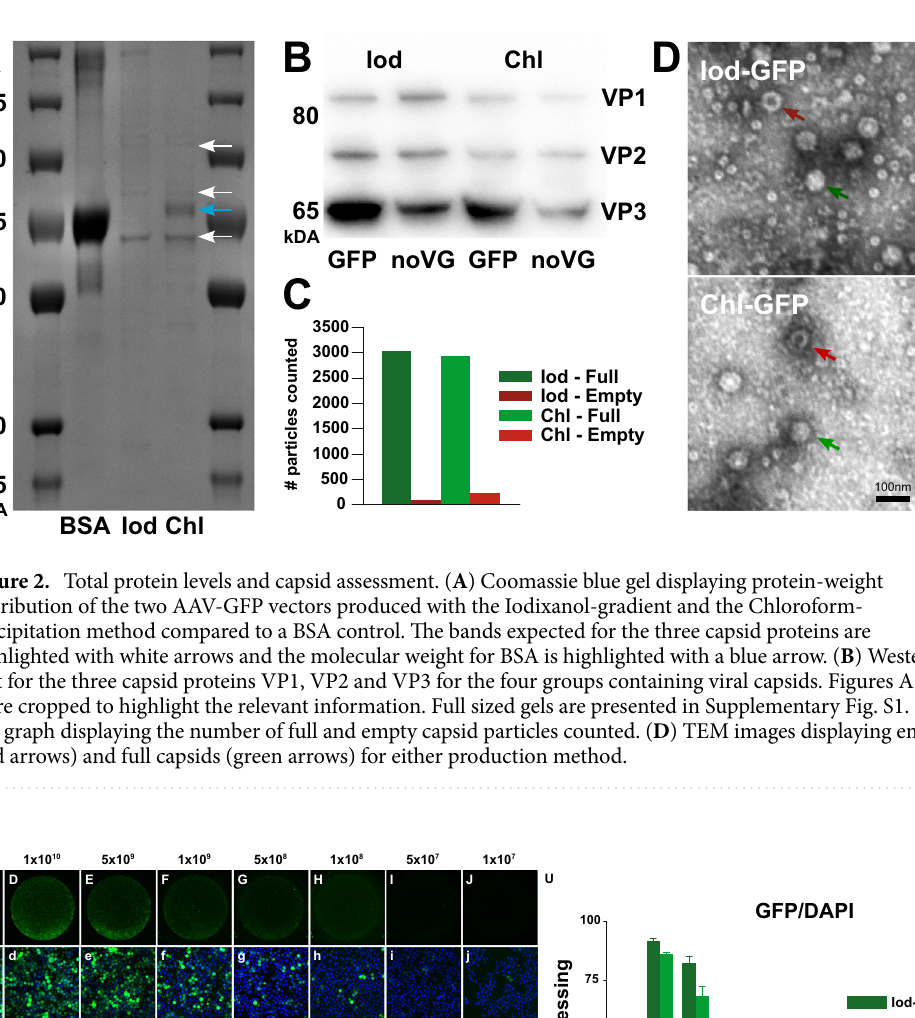
and VP3 for capsid composition. When assessing the total protein content in the Coomassie blue staining, we observed similar profiles between the different production methods. We did however observe a pronounced increase in the amount of a band corresponding in size to BSA in the Chl-batch compared to the Iod-batch (Fig. 2A). To confirm that the bands at the respective locations are indeed the three capsid proteins, VP1, VP2, and VP3, we conducted a Western Blot using a specific antibody. The Western Blot (Fig. 2B) showed similar pat- terns for both production methods, with a stronger band for VP3 compared to VP1 and VP2, consistent with previous studies 63 , indicating a 1:1:10 ratio of the three proteins (data not shown). Quantifications of empty and full AAV capsid particles from transmission electron microscopy (Fig. 2C,D) resulted in 97% and 92% full cap- sids for the Iod-GFP (full: 3029; empty: 93) and Chl-GFP (full: 2943; empty: 224) groups, respectively. Iodixanol‑ and chloroform‑based production methods are equipotent in their ability to trans‑ duce a human cell line. We transduced the human HeLa cell line with a matched, serial dilution of the